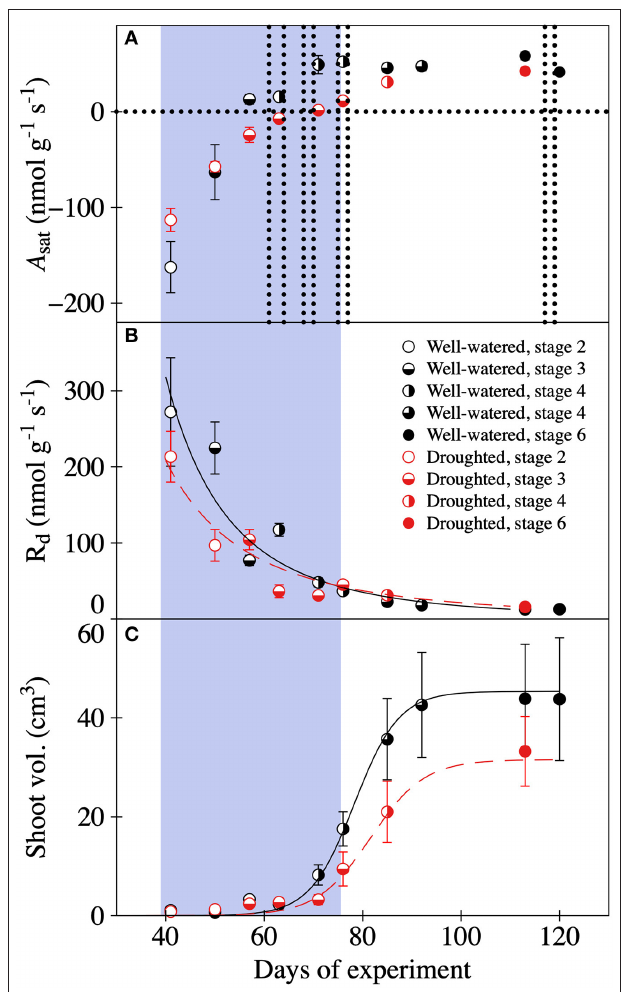
FIGURE 1 | Developmental changes in (A) light saturated assimilation rates ( A sat ), (B) respiration rates (R d ), and (C) shoot volume in well-watered (black symbols) and drought (red symbols) 10-year old P. mariana trees. Variables were measured at different shoot developmental stages: stage 2 swollen bud with the scales still covering the new needles (open circles), stage 3 bud scales diverging but no elongation of the shoot (half-filled circles), stage 4 elongation of twig and needles without needle spreading (left side filled circles), stage 5 elongation of twig needles and needles spread (3/4 filled circles), and stage 6 stagnation of shoot elongation and fully mature needles (filled circles). The gray area indicates the period of water deficiency and the eight vertical dotted lines the 13 C pulse-labeling events. In (B) relationships between day of experiment (x) and R d (y) are y = 4* 107 * x − 3.183 ( R 2 = 0.946) and y = 2*106* x − 2.486, ( R 2 = 0.919) for the well-watered and droughted trees, respectively. (C) Relationships between day of experiment (x) and shoot volume (y) are y = (44.004 + 1.369)/[1 + exp (78.328–x)/4.52] and y = (30.351 + 1.225)/[1 + exp(81.612–x)/5.43] for the well-watered and droughted trees, respectively. Mean ± 1SD, n = 2–3